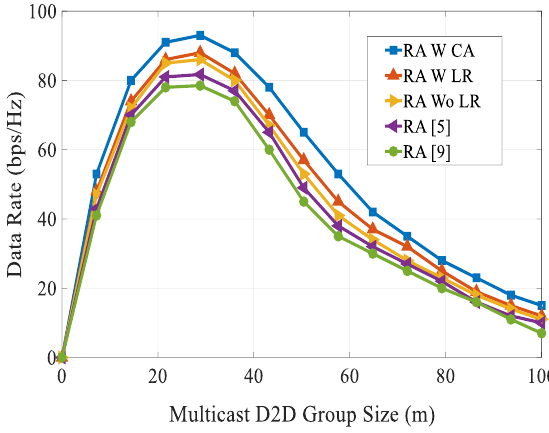
Figure 7. Data rate vs. multicast D2D group size.